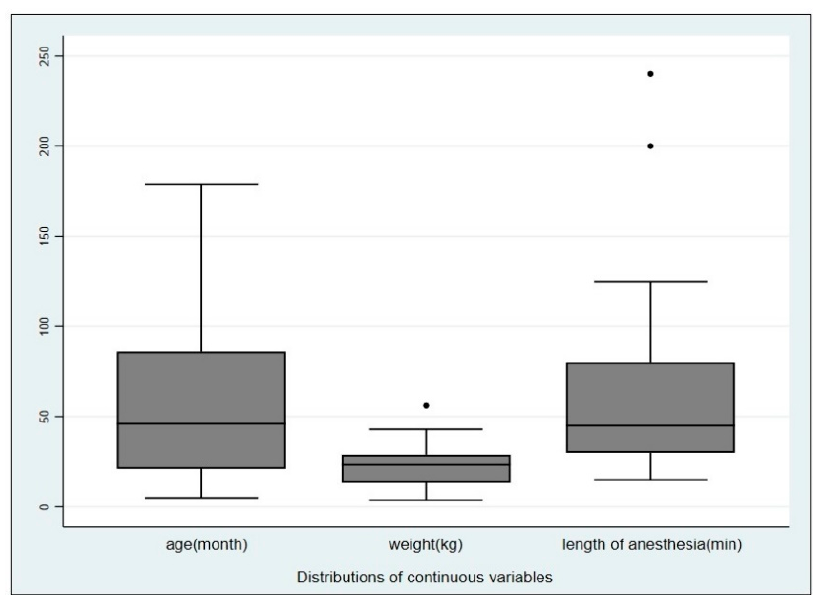
Figure 1. Boxplot of age, weight and length of the anesthesia procedures in the population sampled, displaying the distribution of data.